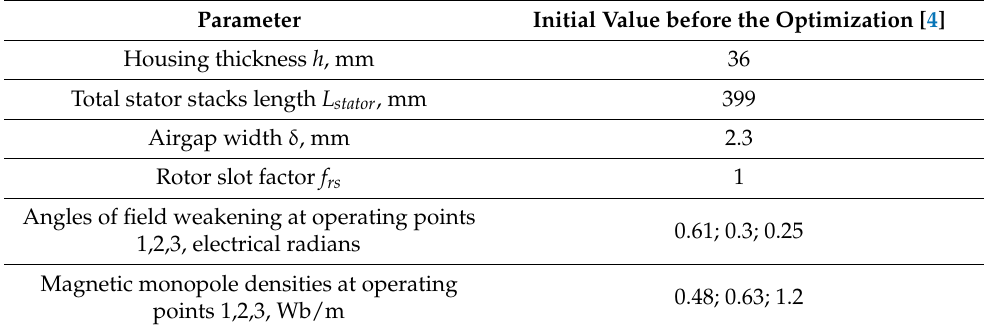
Table 3. Parameters that were varied during the